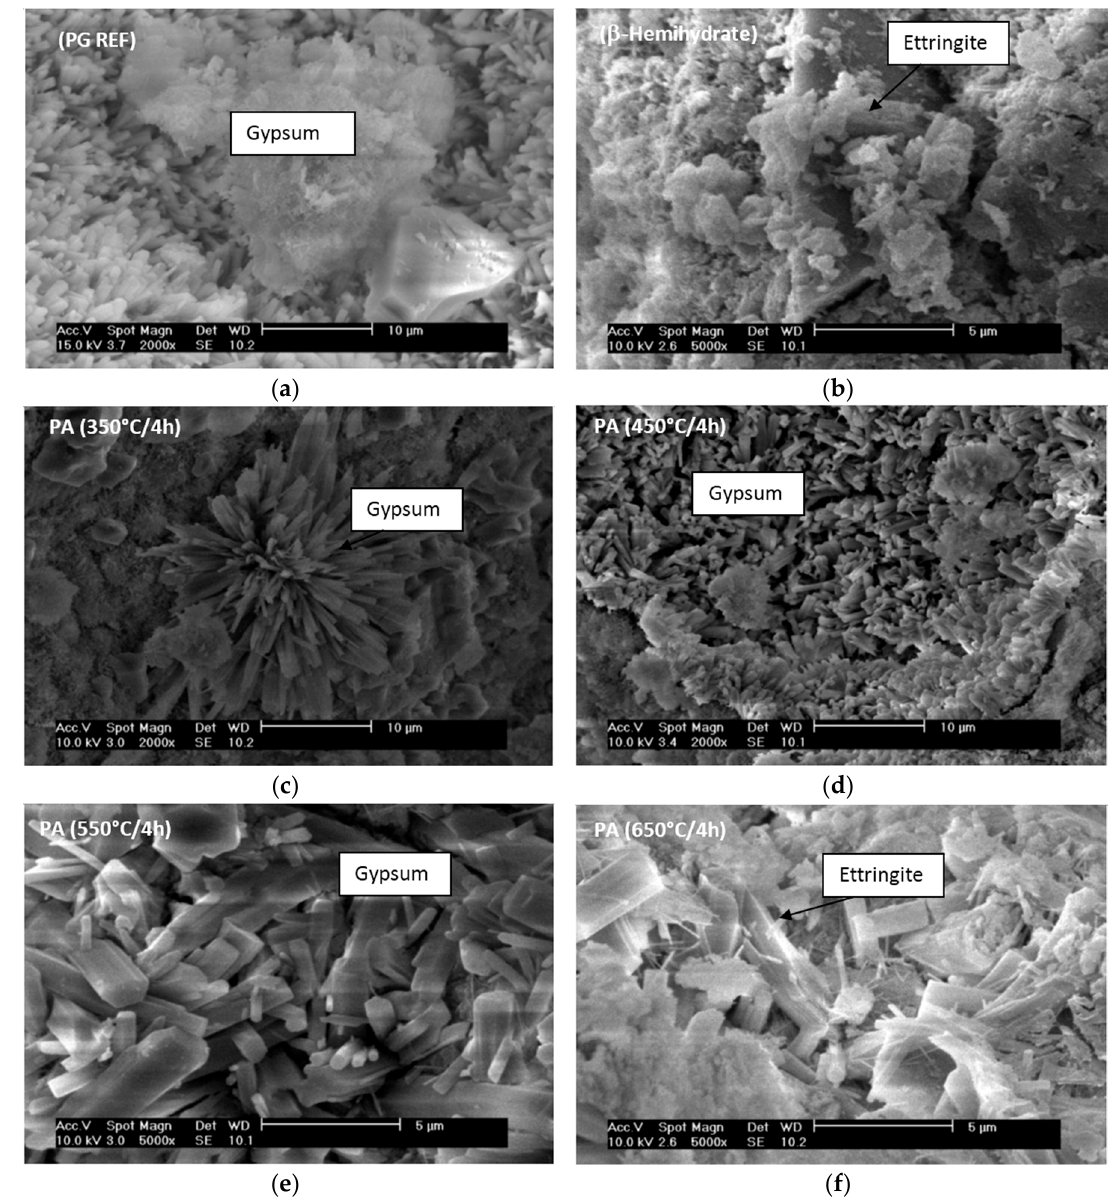
Figure 10. SEM images of self-leveling underlayments after 28 days of curing. ( a ) PG REF; ( b ) β -hemydrate; ( c ) PA 350 °C/4 h; ( d ) PA 450 °C/4 h; ( e ) PA 550 °C/4 h; ( f ) PA 650 °C/4 h.